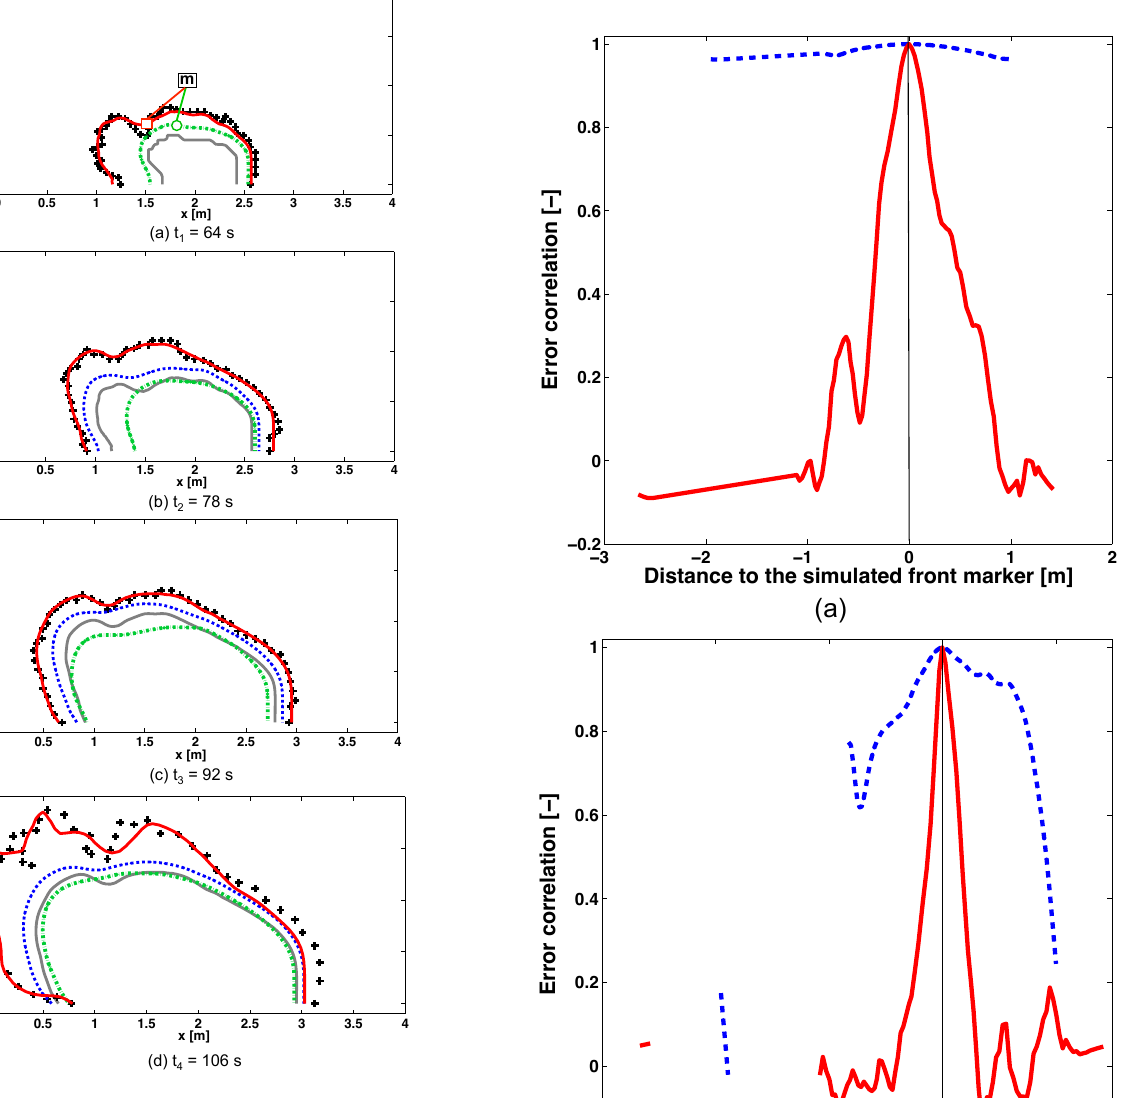
Figure 13. Controlled grassland fire experiment with multiple as- similation cycles from t 0 = 50s to t 4 = 106s. Black crosses cor- respond to observations, the gray solid line corresponds to the ini- tial condition of the assimilation cycle, the green dashed-dotted line corresponds to the free run (without DA), the blue dashed line cor- responds to the mean forecast estimate (without DA for the first observation time or with DA at the previous observation time), and the red solid line corresponds to the mean analysis estimate (with a DA update at the current observation time). Assimilation cycles (a) [50; 64s]; (b) [64; 78s]; (c) [78; 92s]; and (d) [92; 106s]. ciated with the front marker indexed by m in Fig. 13a for the forecast (blue dashed line) and analysis (red solid line) esti- mates. The analysis estimates feature a much reduced length scale compared to the forecast estimates to allow for a spa- tially distributed correction during the EnKF update.